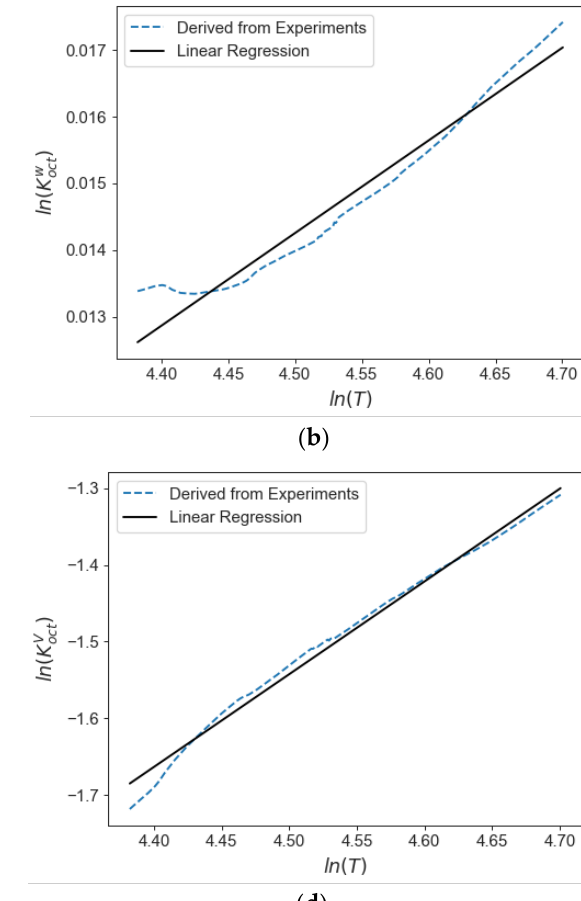
21 of 26 Figure 19. S olubility of n-octane in water in the temperature range of interest. Note: blue bands represent the 95% confidence interval. Furthermore, on the basis of the experimental data obtained in the CREC-VL-Cell, a correlation to obtain the K values for water/octane mixtures in the temperature range of interest and low pressure (1 – 3 atm) is proposed. This correlation is given by the following Equation (65), with the constants involved reported in Table 7. A comparison with calcu- lated values from experimental results is also reported in Figure 20, showing the adequate fitting of the experimental values by this correlation. ln 𝐾 𝑖𝑝 = 𝑚 ln 𝑇 + 𝑏 (65) Table 7. Constants for K-value correlation of water/n-octane system.